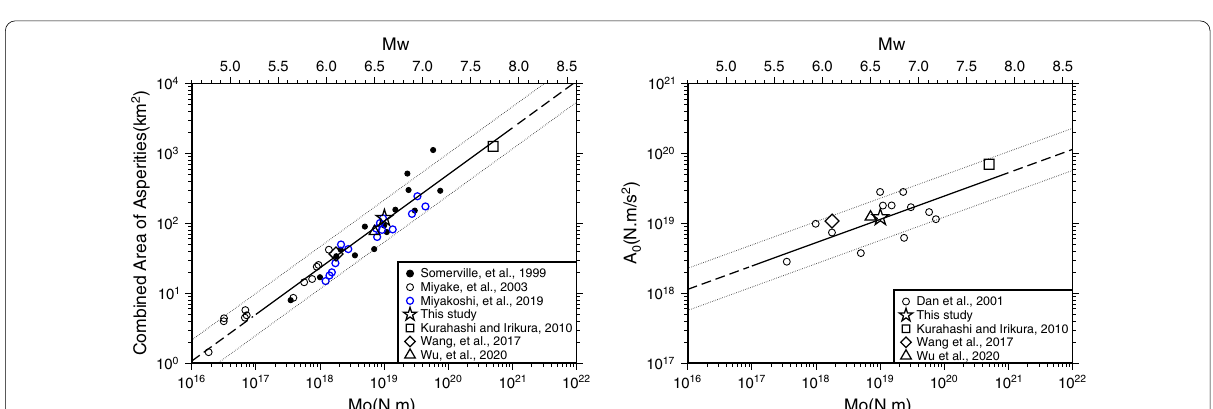
Fig. 6 Empirical scaling relationships of inner fault parameters between the combined area of asperities and the seismic moment (left), and between the flat amplitude of the acceleration source spectrum in the short period and the seismic moment (right). The thick lines represent the regression equations derived by Somerville et al. (1999) in the left panel and by Dan et al. (2001) in the right panel. The dashed lines represent extrapolation of regression equations. The dotted lines denote the factors of 1/2 and 0.5 for the